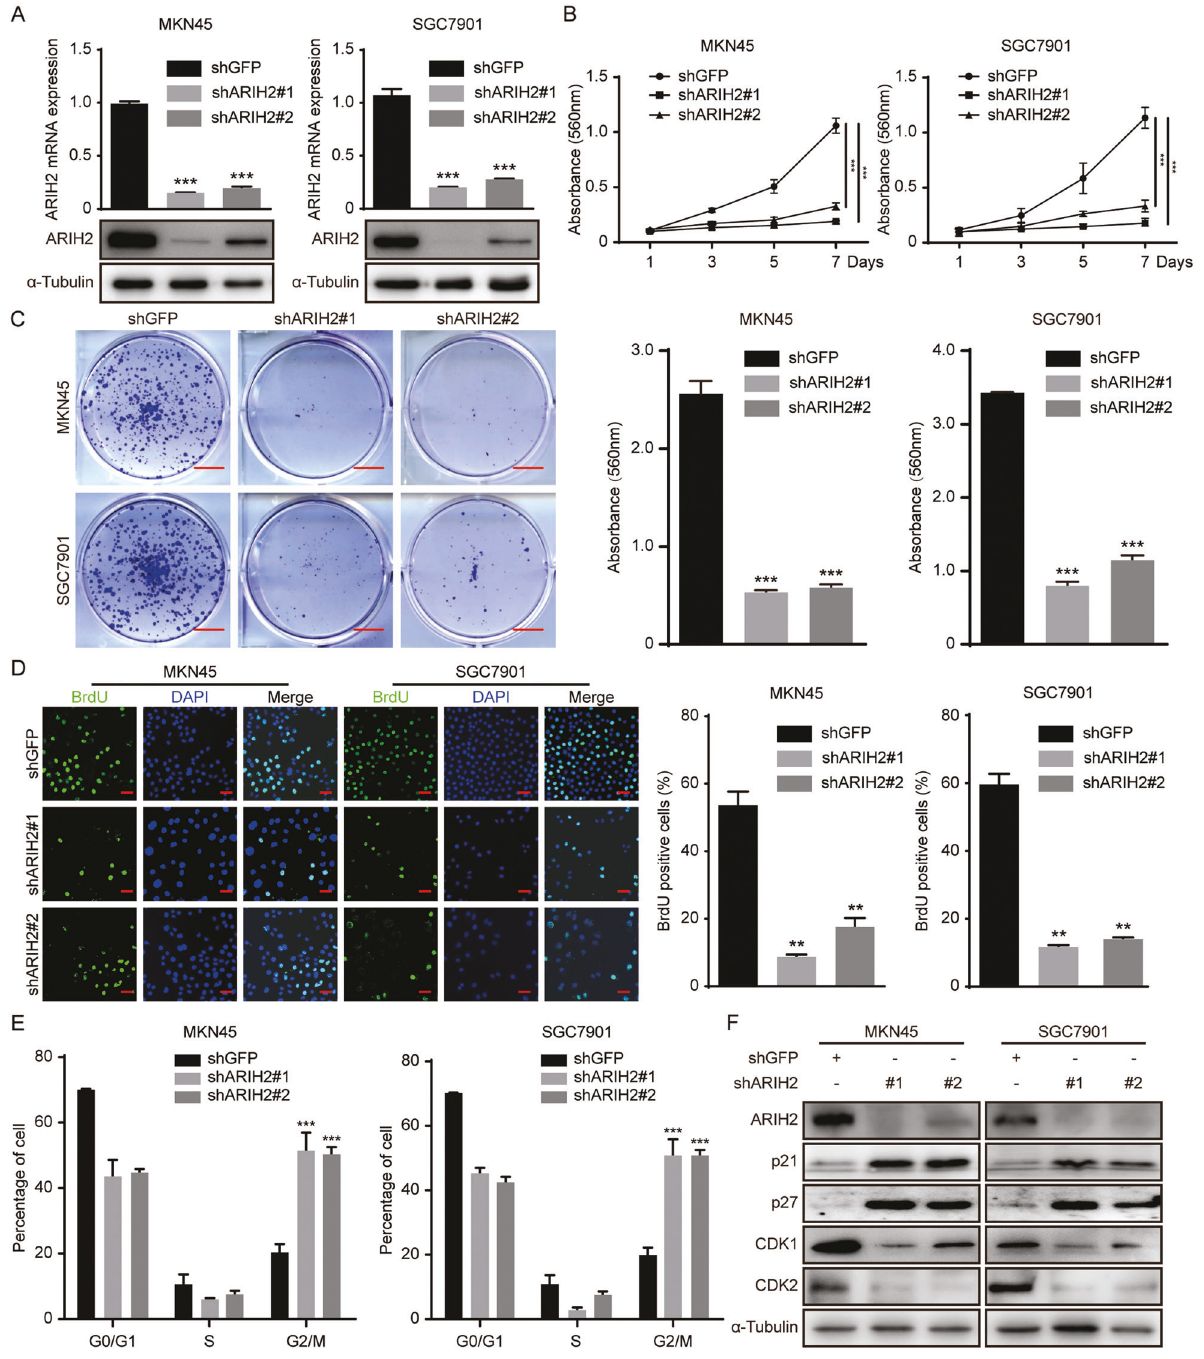
Fig. 2 Downregulation of ARIH2 expression inhibits cell proliferation and regulates the cell cycle progression of GC cells. A Western blot and quantitative PCR assays were performed to characterize the expression of ARIH2 in the control and ARIH2-knockdown MKN45 and SGC7901 cells. B MTT assays were performed to test the proliferation of the control and ARIH2-knockdown MKN45 and SGC7901 cells. C Plate cloning assays were performed to examine the proliferation of the control and ARIH2-knockdown MKN45 and SGC7901 cells. D BrdU incorporation assays were performed to detect the amount of DNA synthesis in the control and ARIH2-knockdown MKN45 and SGC7901 cells. Data were analyzed using two-tailed Student ’ s t tests. Scale bar = 50 μ m. E , F The cell cycle was analyzed in MKN45 and SGC7901 cells by fl ow cytometry, and cell cycle-related proteins were detected by Western blot assays. All data were expressed as the mean ± SD. Student ’ s t test was performed to analyze signi fi cance. * P < 0.05, ** P < 0.01, *** P < ARIH2-overexpressing MKN45 and SGC7901 cells. Western blot Moreover, the co-IP results demonstrated that endogenous ARIH2 assays showed that p21 expression was signi fi cantly decreased and p21 also coprecipitated reciprocally (Fig. 4B). These results after ARIH2 overexpression while increased after MG132 addition, indicated that a protein interaction is present between ARIH2 and indicating that ARIH2 regulated p21 at the post-transcriptional p21. Next, the proteasome inhibitor MG132 was added to the